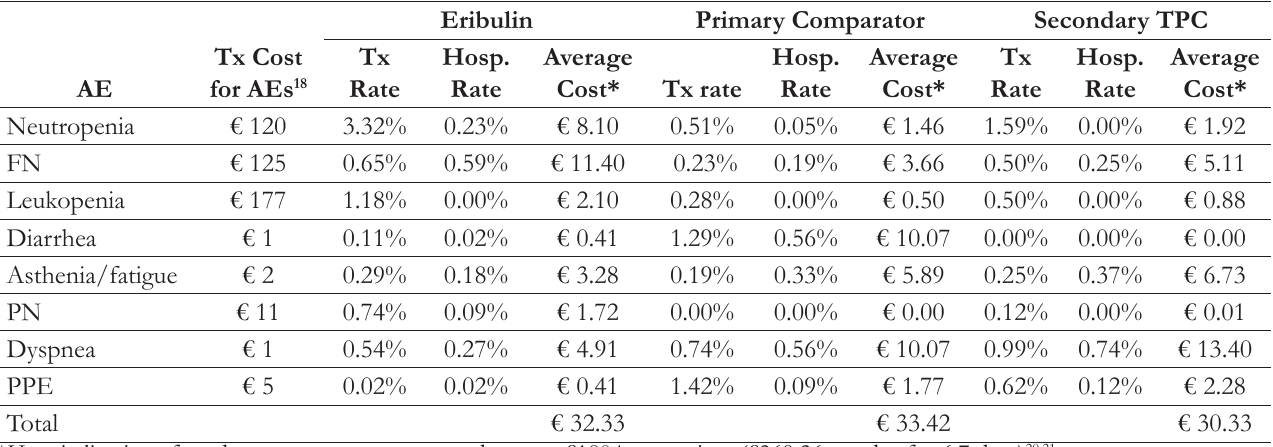
Table 2. Monthly Per Patient Costs Attributed to Grade 3/4 Adverse